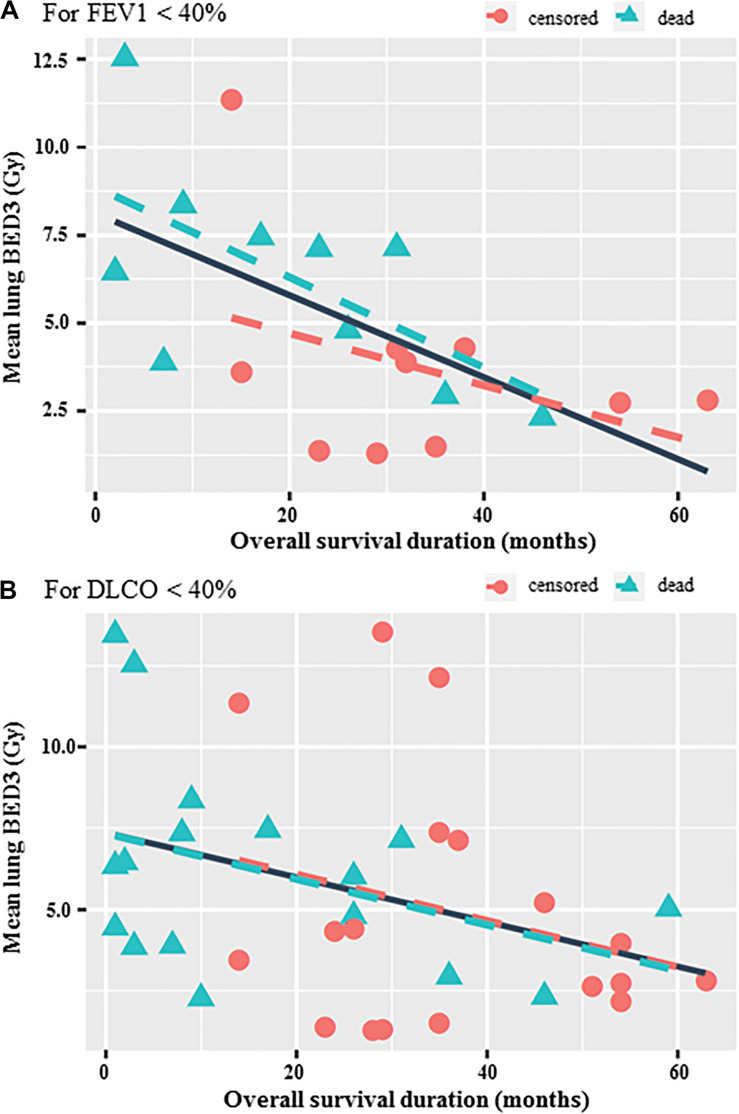
Correlation between OS and mean lung BED3 for patients with FEV1 < 40% (r = –0.6, p = 0.005) (A) and with DLCO < 40% (r = –0.36, p = 0.033) (B). The solid line shows correlation independently of the censored or dead patients.